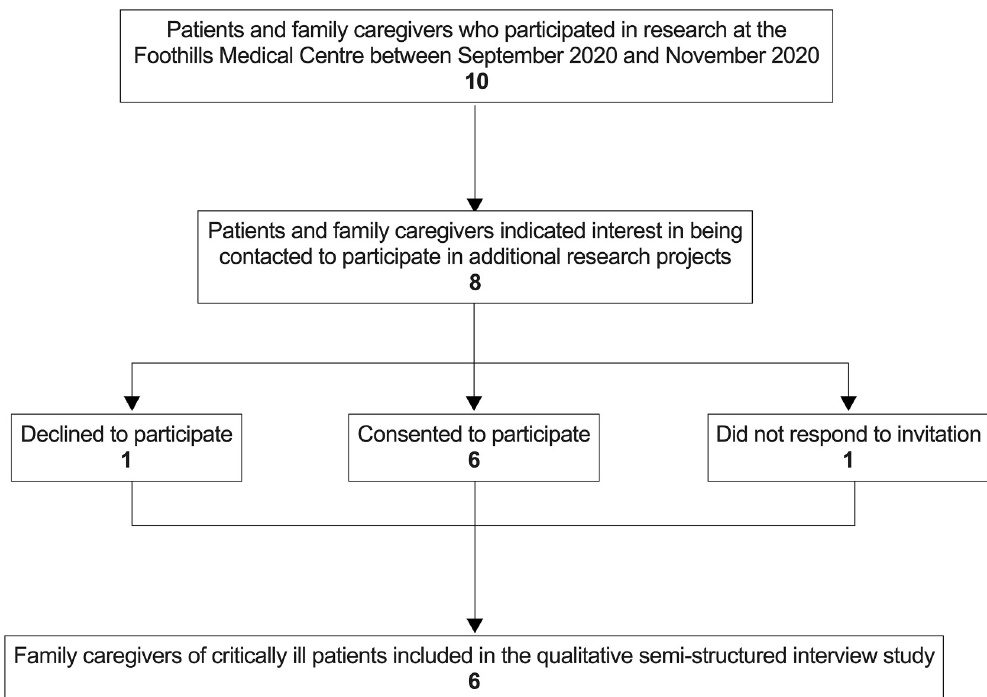
Fig 1. Flow diagram of selection of family caregivers for